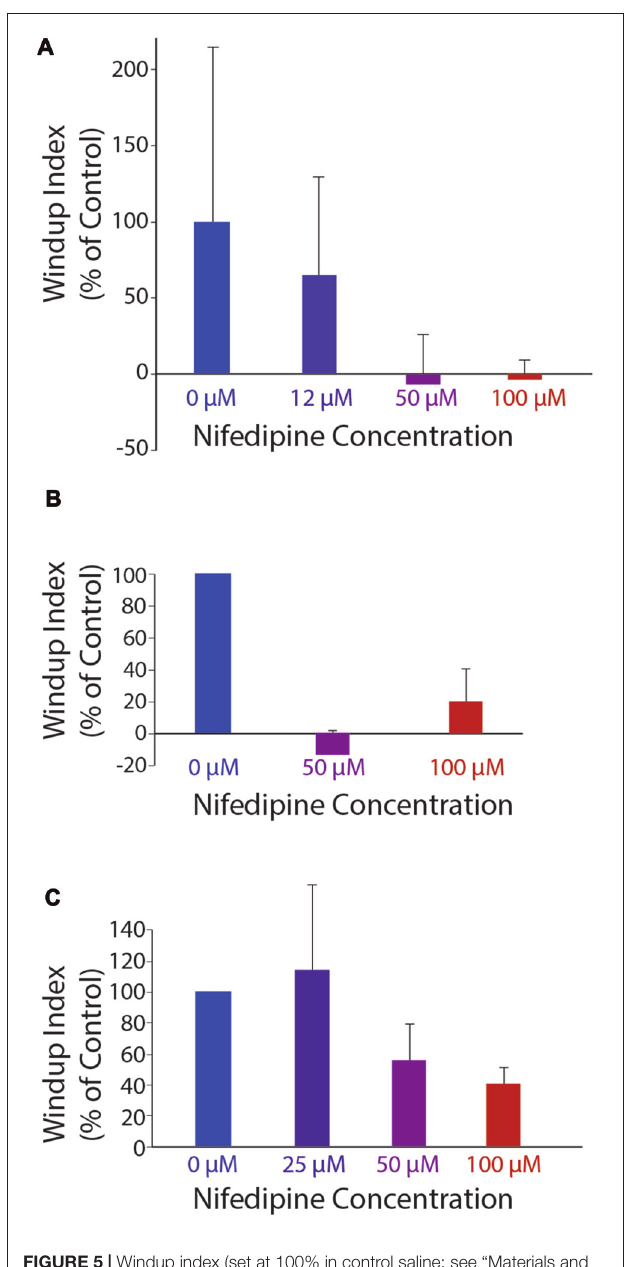
FIGURE 5 | Windup index (set at 100% in control saline; see “Materials and Methods” section) as a function of nifedipine concentration. (A) Mechanically evoked (4-g von Frey filament) flexion reflex windup, in one animal. (B) Mechanically evoked flexion reflex windup across all animals for concentrations of nifedipine tested in more than one animal ( n = 5, 2 and five animals for control, 50 µ M and 100 µ M, respectively). (C) Electrically evoked flexion reflex windup across all animals for concentrations of nifedipine tested in more than one animal ( n = 13, 3, 4 and 13 animals for control, 25 µ M, 50 µ M, and 100 µ M, respectively). Error bars are standard deviation for (A) and standard error of the mean for (B,C) . n = 2; 10 µ M: n = 4; 20 µ M: n = 2; 50 µ M: n = 2), no clear